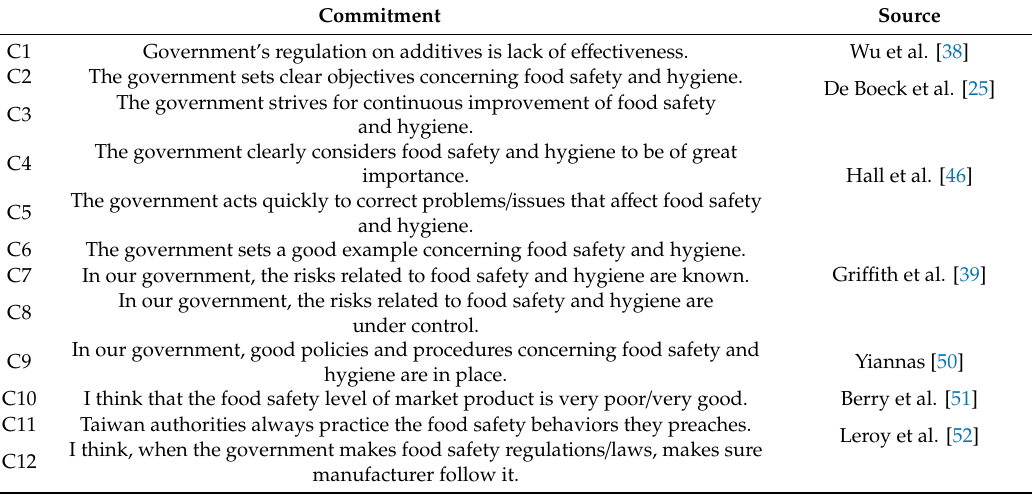
Table 2. Indicators of food safety gap between consumers and